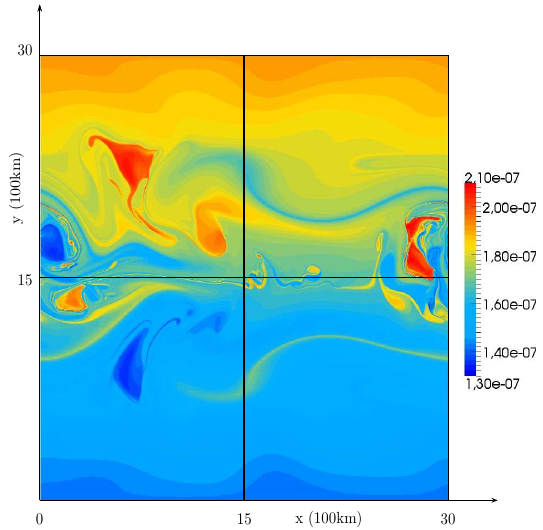
Fig. 2. Potential vorticity (in (ms) − 1 ) after 250 days in exp11. The Fig.2. Potentialvorticity(in ( ms ) − 1 )after250daysinexp11. Theenstrophycascadehastransportedpotentialvorticitytosmallscales. enstrophy cascade has transported potential vorticity to small scales. Thetwodipoleshavedisintegratedleavingsmallscalevortices,filamentsandfrontsbehind.Theyareasignatureoftheturbulentenstrophy cascade. The two dipoles have disintegrated, leaving small scale vortices, current system. Part I: flow structure, eddy flux, and observa- Anderson,D.L.T.andA.E.Gill(1979),“Betadispersionofinertial filaments and fronts behind. They are a signature of the turbulent tionaltests” J.Phys.Oceanogr. 38 ,29–43 Waves” J.Geophys.Resea. 84 ,1836–1842. Chelton,D.B.,M.G.Schlax,R.M.Samelson(2011)GlobalObser- Bofetta,G.andR.E.Ecke(2012)“Two-DimensionalTurbulence” enstrophy vationsofNonlinearMesoscaleEddies Prog.inOceanogr. 91 , Annu.Rev.FluidMech. 44 ,427–451. 167-216.doi:10.1016/j.pocean.2011.01.002 Capet,X.,J.C.McWilliams,M.J.MolemakerandA.F.Shchepetkin Farge,M.andR.Sadourny(1990),“Wave-vortexdynamicsinro- (2008),“Mesoscaletosubmesoscaletransitioninthecalifornia